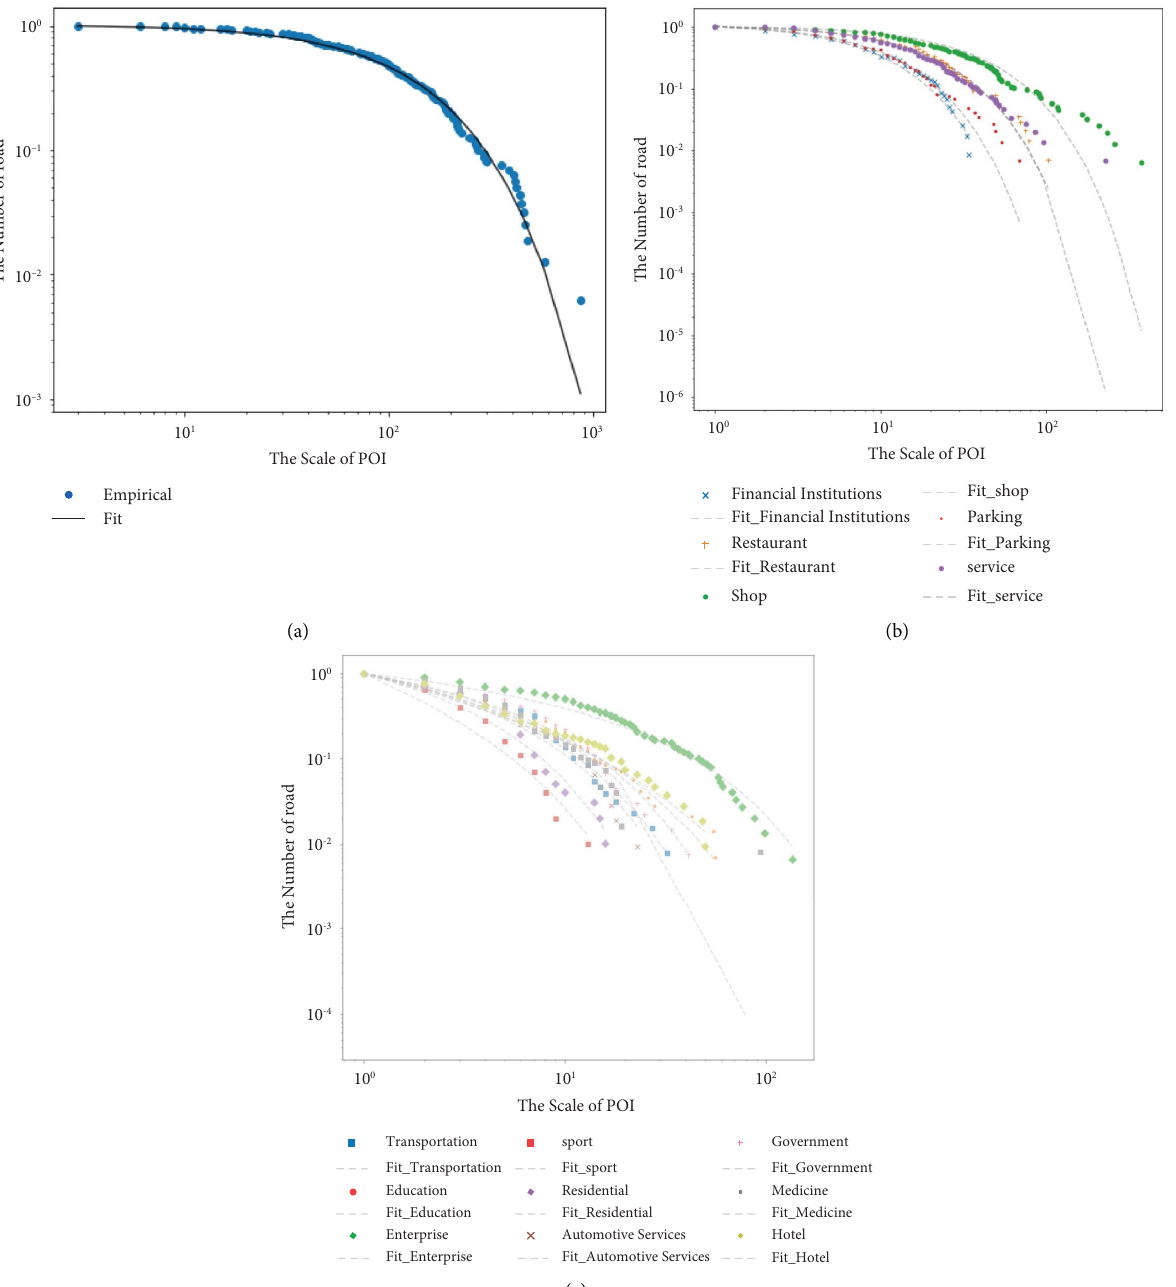
Figure 6: Te distribution of the scale of POIs along the sampled road: (a) the distribution of the total scale of POIs along the roads, (b) the distribution of retail service, living service, catering service, fnancial service, and parking service types and the exponential distribution ft line, and (c) the distribution of other types of POI and the exponential cut-of power-law distribution ft